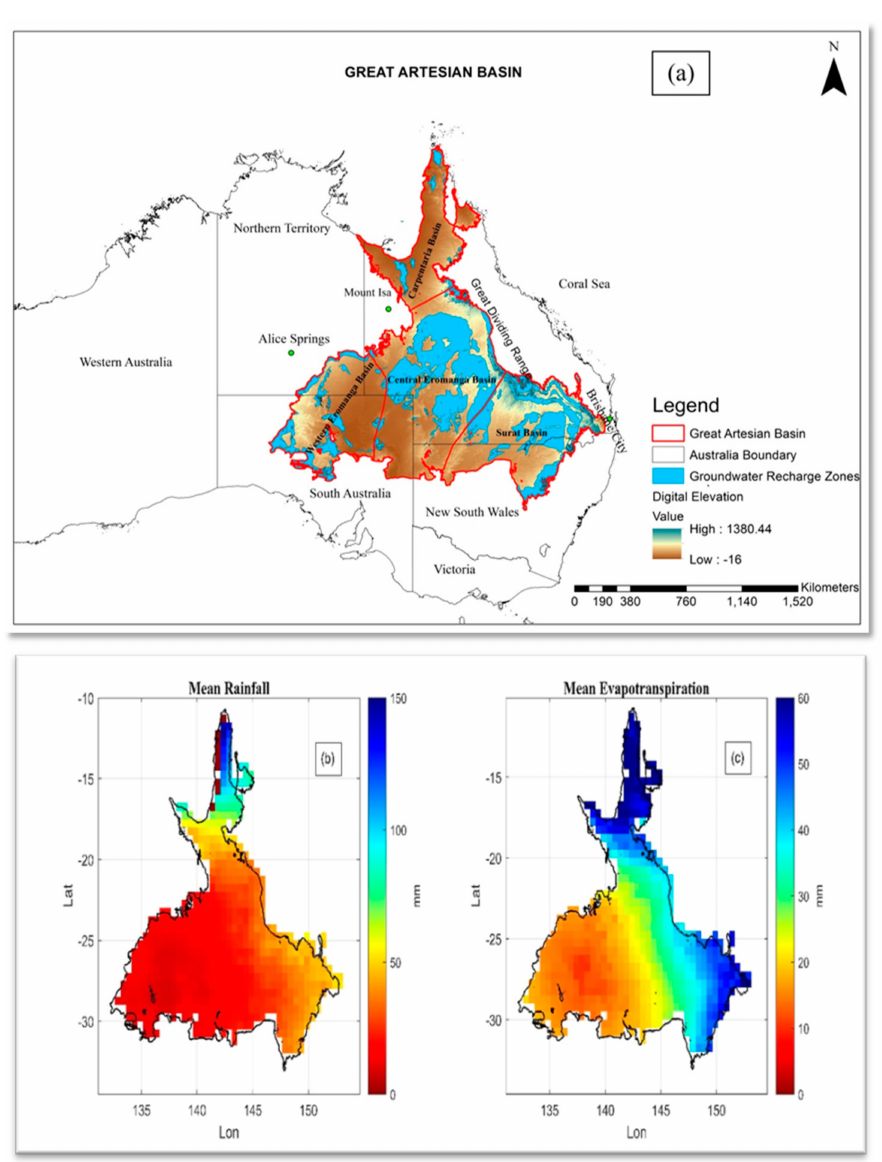
Figure 1. ( a ) Study area showing the Great Artesian Basin, its four main sub-basins: Surat (Southeast Region), Central Eromanga (Central Area), Western Eromanga (Southwest Region) and Carpentaria (Northern Region), groundwater recharge zones, and digital elevation values variations. Groundwa- ter recharge zones are sourced from Geoscience Australia. ( b ) Spatial patterns of average rainfall from silos based gridded rainfall (2002–2017) ( c ) Mean evapotranspiration over the GAB from Global Land Data Assimilation System based evapotranspiration (2002 and